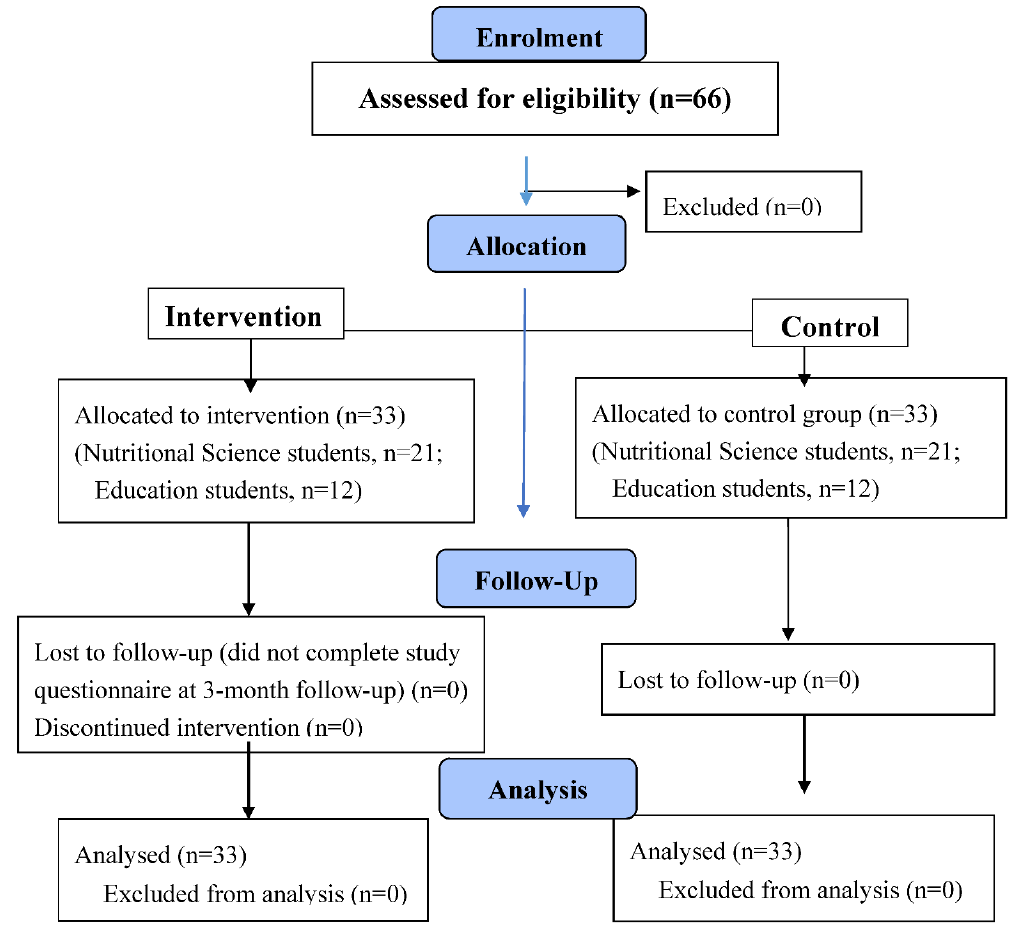
Figure 1. CONSORT 2010 Flow Diagram.